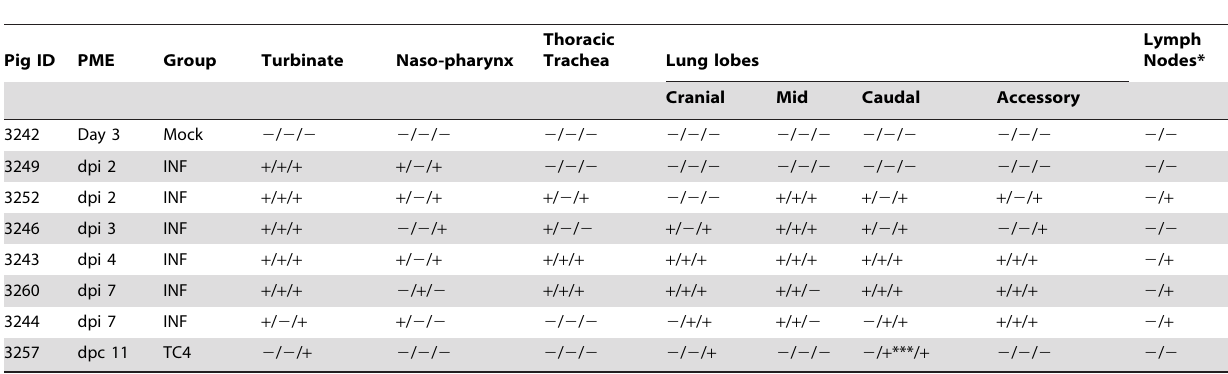
Table 1. Qualitative results for the detection of virus in tissues collected from challenged or contact exposed pigs by virus re- isolation, immunohistochemistry (IHC) and RRT- PCR.